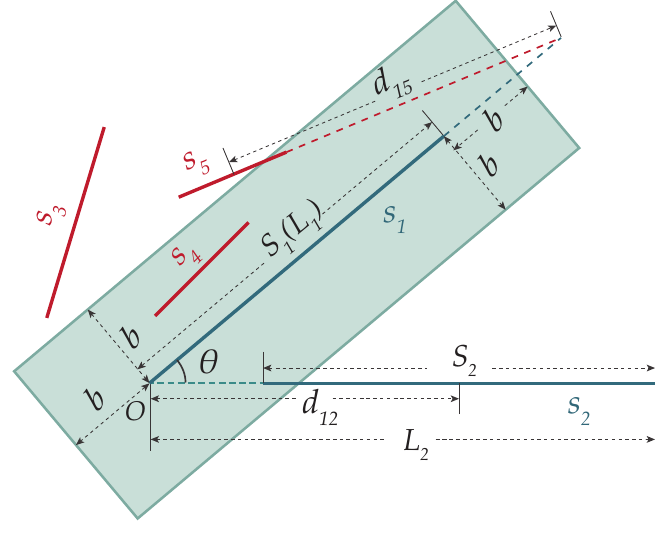
Figure 3. Diagram of the LIL structure.